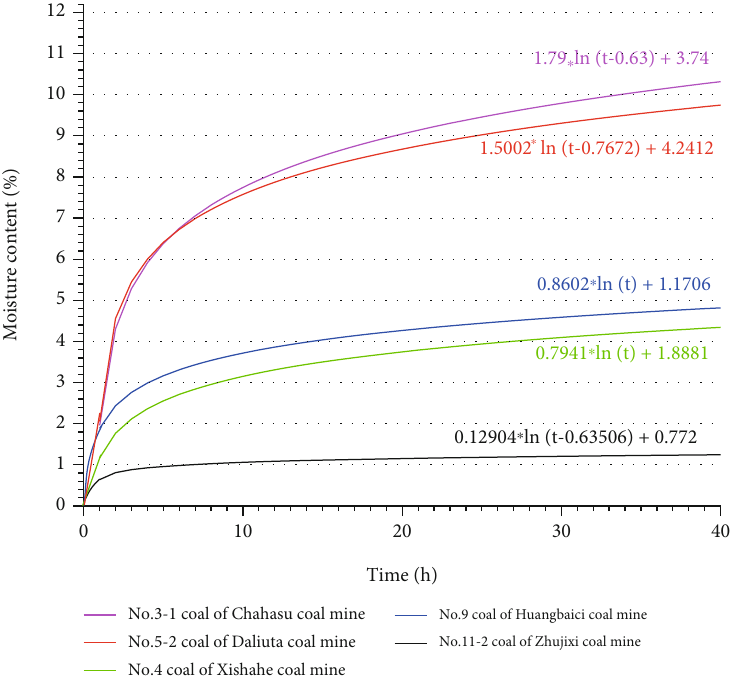
Figure 3: Relationship between time and moisture content of coal